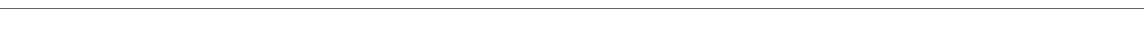
FigUre 5 | Zfx is required for homeostasis of invariant natural killer T cell (iNKT) cells. (a) Zfx deficiency in double-positive thymocytes inhibits iNKT cell maintenance. Shown is the percentage of TCR β + CD1d-tetramer + iNKT cells in the thymus, liver, and spleen of control and conditional knockout (CKO) (CD4-Cre Zfx flox/y ) mice. Data are representative of 1–3 mice over two different experiments. (B) Quantification of iNKT cells in control and CKO mice. Top row shows the percentage of TCR β + CD1d-tetramer + iNKT cells, and the bottom row contains the number ( × 10 6 ) of iNKT cells in the thymus, liver, and spleen. ** P < 0.005 and *** P < 0.0005. (c) Zfx deficiency causes decreased formation of stage 0 iNKT cells. Shown is the number of CD1d-tetramer + CD24 + stage 0 cells after enrichment for CD1d-tetramer + cells by magnetic-activated cell sorting. Shown is quantification of the number ± SEM of stage 0 iNKT cells. * P < 0.05. (D) Zfx deficiency impairs iNKT cell development. Shown is quantification of the percentage of cells in stage 1, 2, and 3 of iNKT cell development based on expression of CD44 and NK1.1. Data are representative of 1–3 mice in two independent experiments. (e) iNKT cell developmental defect is intrinsic to the bone marrow compartment. Shown is expression of TCR β and CD1d-tetramer of Zfx-deficient iNKT cells in the thymus, liver, and spleen after reconstitution of irradiated recipients with 1:1 mixture of wild-type and CKO bone marrow. (F) Quantification of iNKT cells in bone marrow chimeric mice. The top row shows the percentage of Zfx-deficient TCR β + CD1d-tetramer + iNKT cells in thymus, liver, and spleen. The bottom row shows the number ( × 10 6 ) of iNKT cells in the thymus, liver, and spleen. * P < 0.05, ** P < 0.005, and *** P <